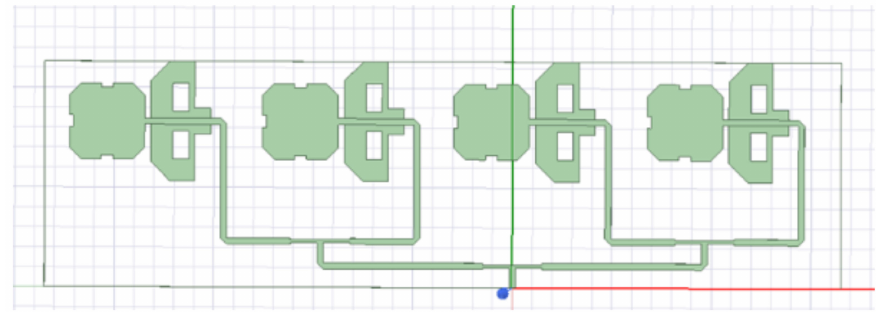
Figure 5. Broadband microstrip antenna array